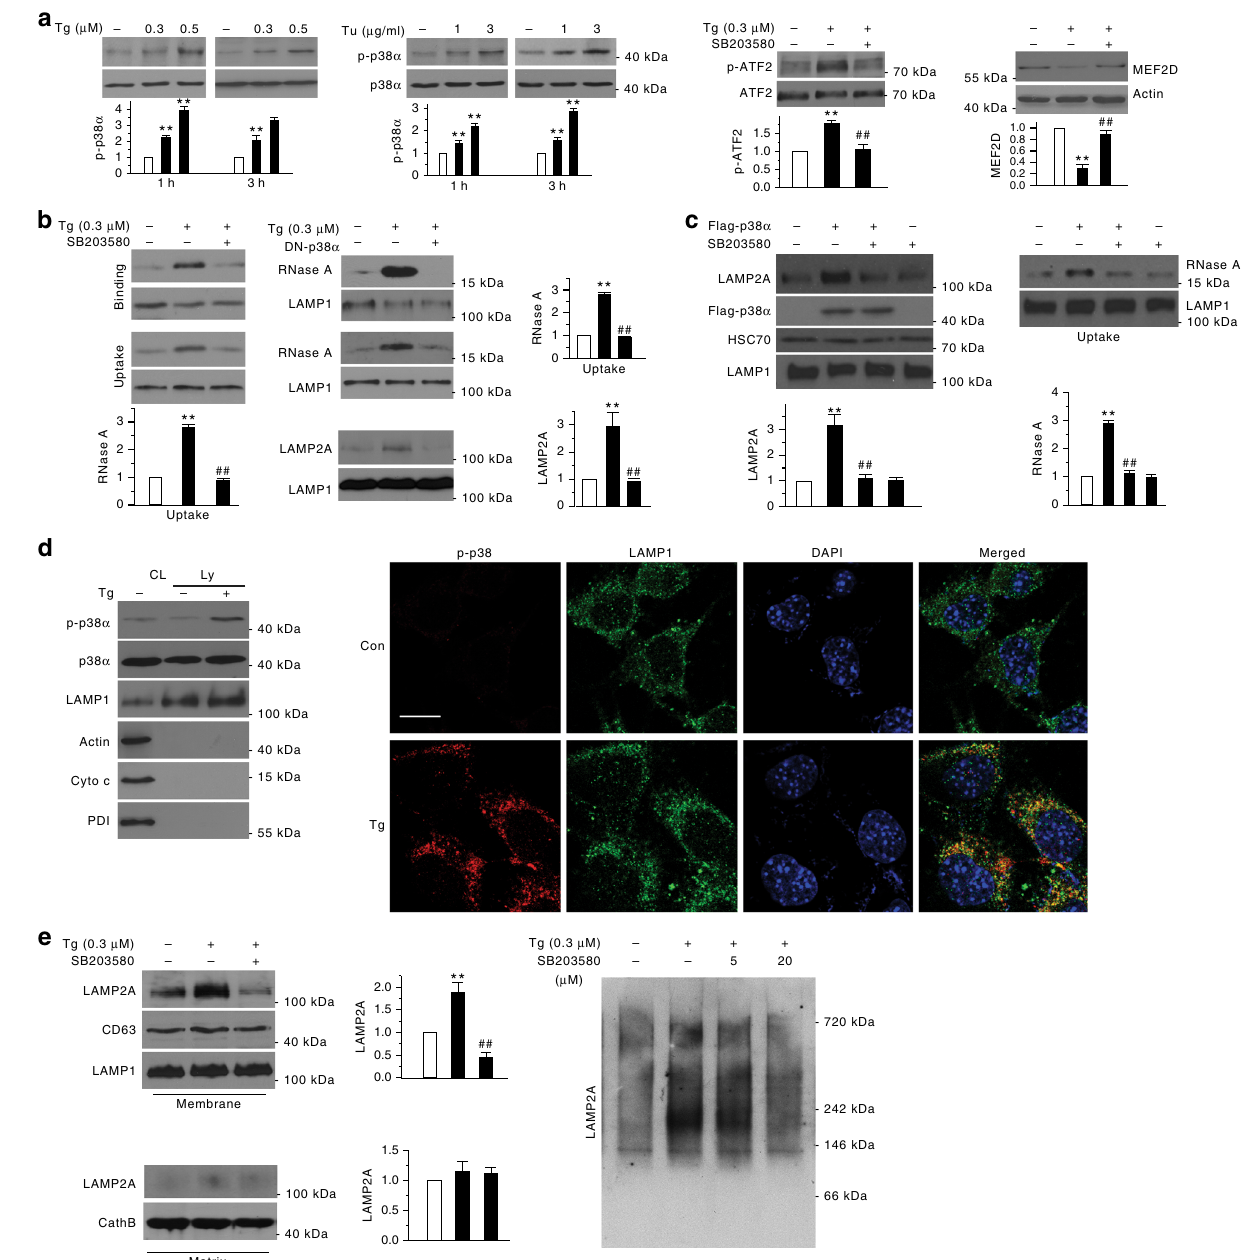
Fig. 3 p38 MAPK mediates ER stress-induced CMA. a ER stress activates p38 α MAPK. Phospho-p38 α MAPK (p-p38 α ) levels were increased in SN4741 cells after exposure to Tg or Tu for 1 h or 3 h (left and middle sets of panels). Tg (3 h) increased the level of p38 MAPK substrate p-ATF2 (activating transcription factor 2) in SN4741 cells and Tg (12 h) decreased the level of MEF2D (right set of panels). b Inhibition of p38 MAPK prevents ER stress-induced CMA activation. CMA activity was determined by lysosome binding (top left) and uptake (bottom left) assays using a commercially puri fi ed CMA substrate RNase A following incubation of lysosomes puri fi ed SN4741 cells exposed to Tg with or without SB203580 for 12 h. SN4741 cells were transfected with dominant-negative p38 α MAPK (DN-p38 α ) or control vector, treated with Tg as described above, and assayed for RNase A binding and uptake (right top and middle panels). Bottom shows the levels of LAMP2A in lysosomes under various conditions. c Increasing p38 MAPK activity is suf fi cient to activate CMA. Lysosomes isolated from SN4741 cells transfected with constructs as indicated were blotted for LAMP2A and Hsc70 (left) and tested for RNase A uptake (right). d ER stress increases the level of p-p38 α MAPK on lysosomes. Cytosolic fraction (CL) and puri fi ed lysosomes (Ly) isolated from SN4741 after Tg treatment (0.3 μ M, 2 h) were blotted for various proteins as indicated (left panel: LAMP1, lysosome marker; PDI, ER marker; cytochrome C (Cyto C), mitochondrial marker) or were analyzed by immunocytochemistry (right panel. Scale bar = 10 µ m). e SB203580 attenuates ER stress-induced increase of LAMP2A on lysosomal membrane. SN4741 cells were exposed to Tg for 12 h with or without 1 h SB203580 pretreatment. Lysosomal membrane and matrix fractions were analyzed for LAMP2A (left). Puri fi ed lysosomes were blotted for oligomerized LAMP2A (right). Quanti fi cations are shown for a , b , c , and e ( n = 3 (ANOVA with Turkey test); ** p < 0.005 vs. control and ## p < 0.005 vs. corresponding challenge